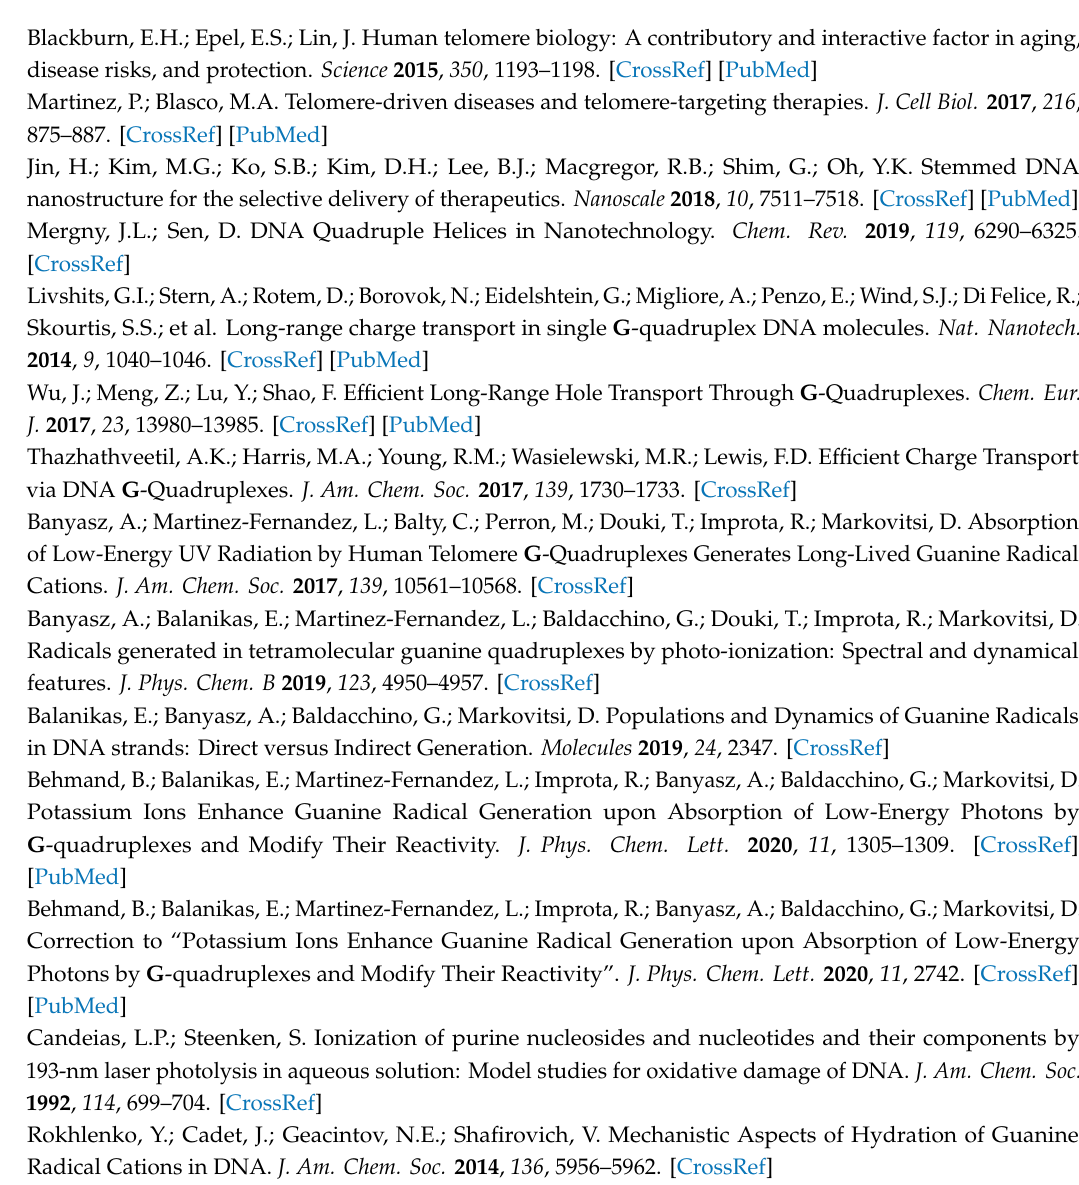
Supplementary Materials: The following are available online, Figure S1. Survival probability of the total radical population; Figure S2. E ff ect of excitation intensity and oxygen on the transient signals; Figure S3. Steady-state di ff erential absorption spectra; Figure S4-melting